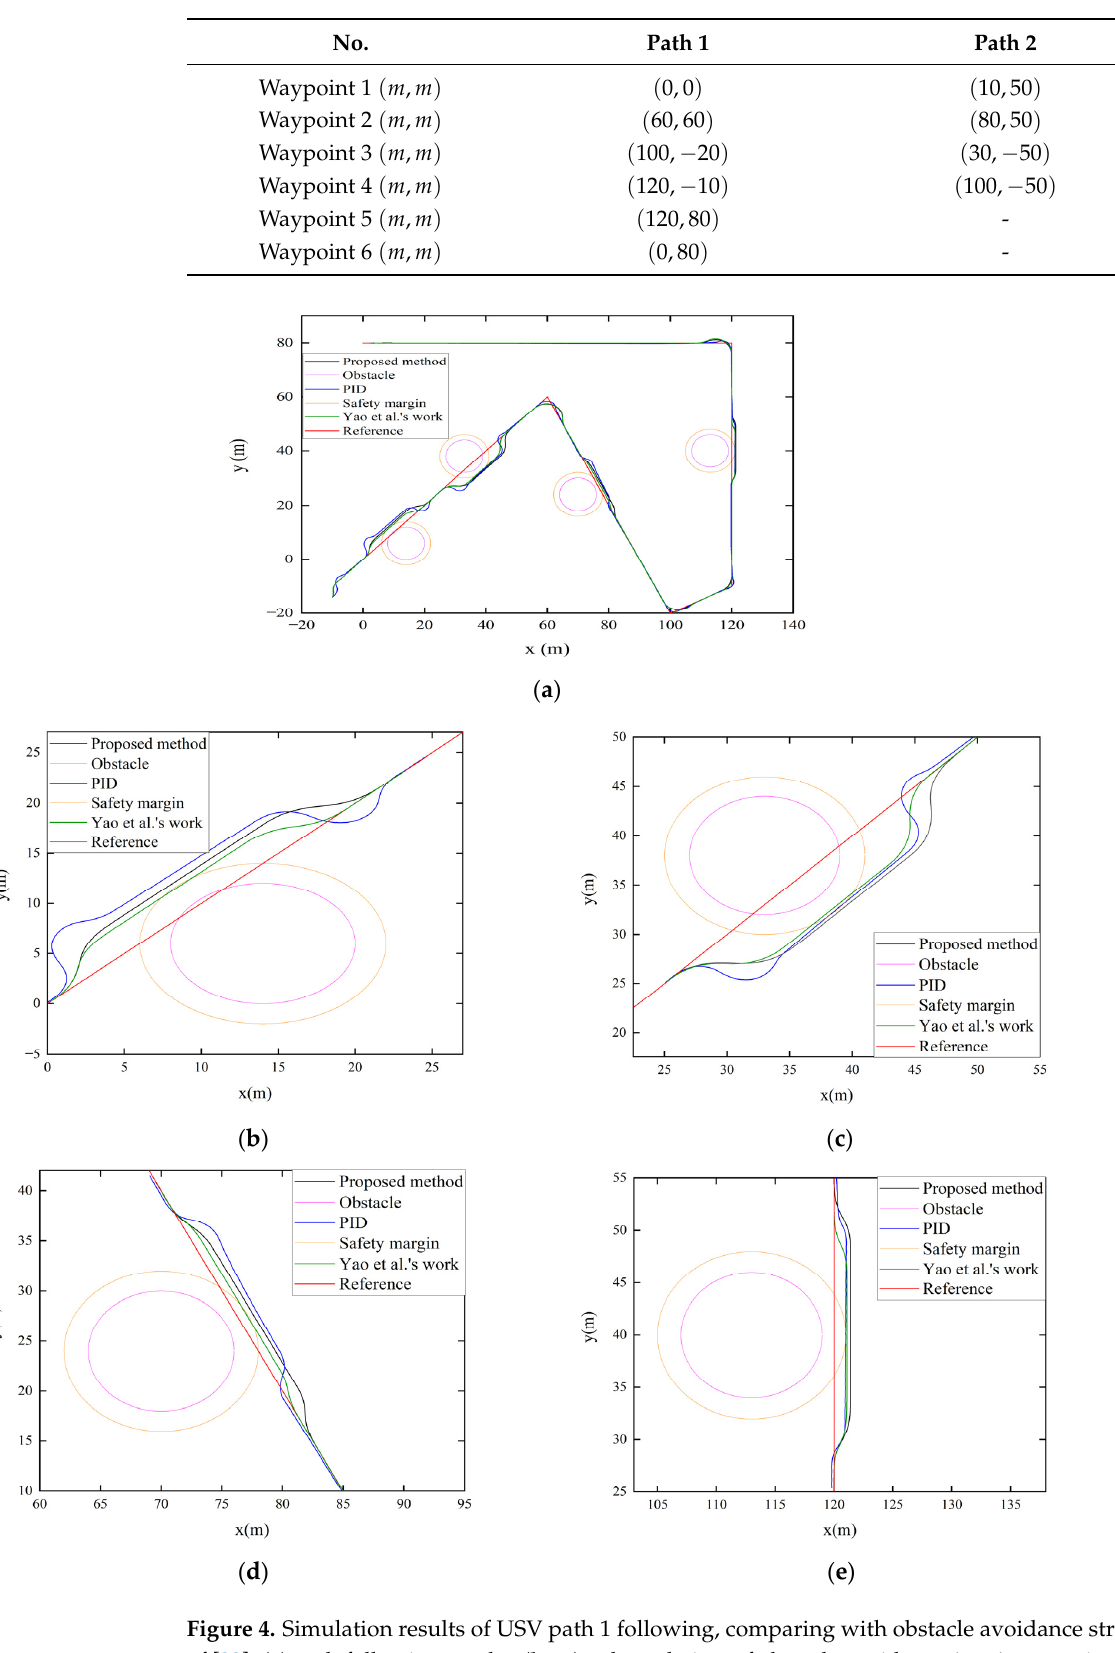
Table 2. Waypoints of the desired path 1 and 2.